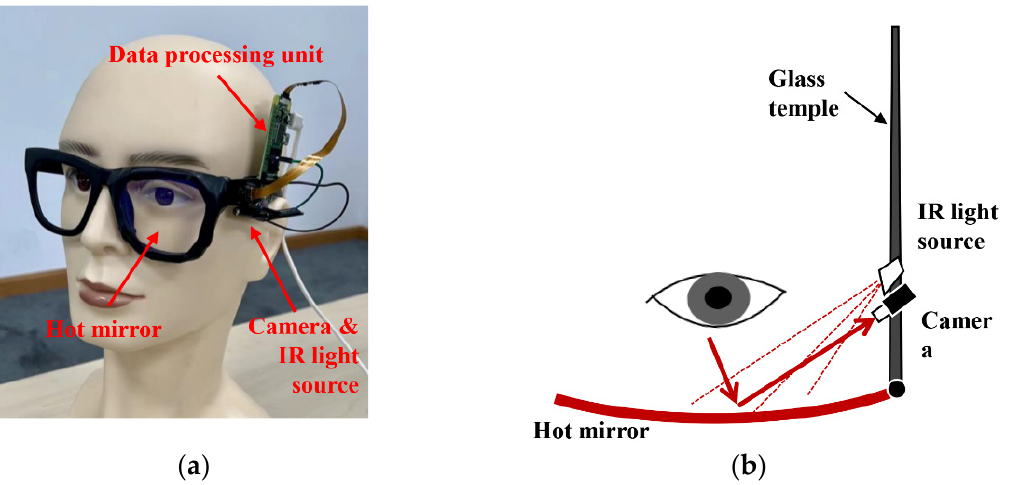
Figure 2. The hardware structure and the optical path of the wearable glass prototype. ( a ) Key components of the wearable glass; ( b ) The optical path of the camera.